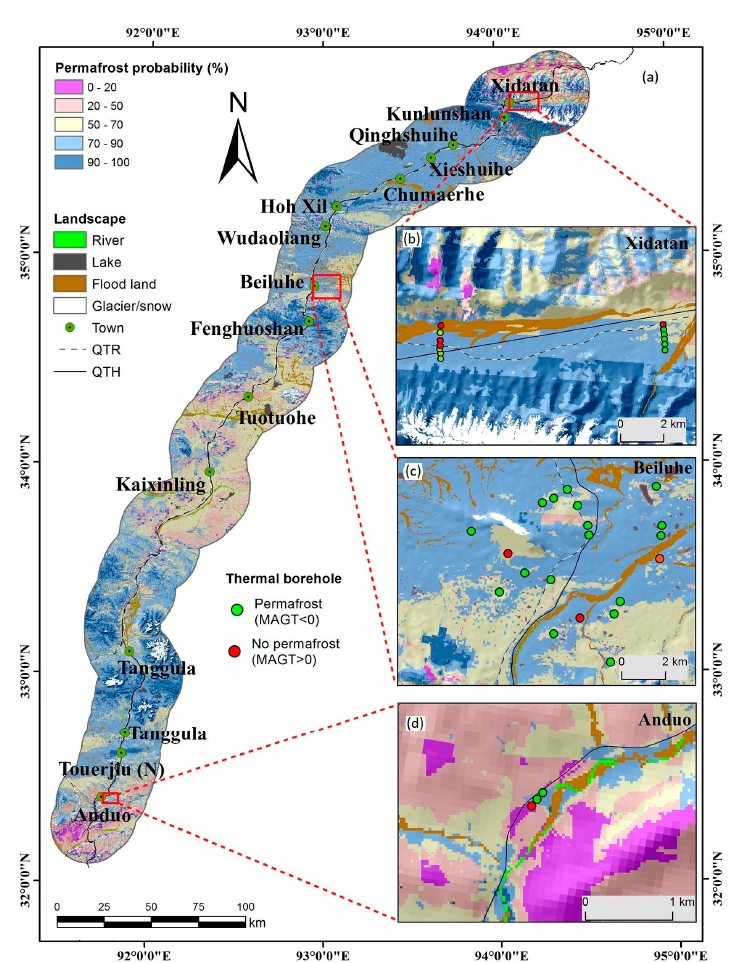
Figure 5. Modeled permafrost probability distribution in the all QTEC excluding rivers, lakes, and glacier surfaces ( a ), the Xidatan area (North boundary) ( b ), Beiluhe basin (central area) ( c ), and Anduo area (South boundary) ( d ).